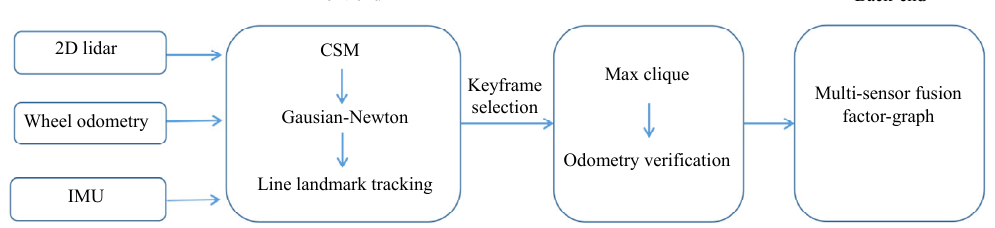
Fig. 2 Framework of SLAM system.